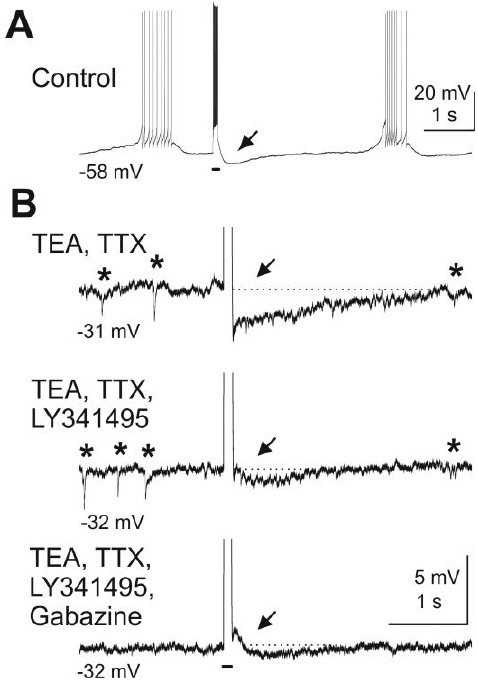
Figure 3. Blockade of mGluRs reduces granule cell-mediated feedback inhibition of mitral cells. Depolarizing current pulses injected into a mitral cell evoked granule cell-mediated feedback IPSPs. ( A ) A depolarizing current pulse (100 ms, 300 pA, indicated by bar beneath the trace) evoked a burst of action potentials followed by an IPSP (at arrow). ( B ) After wash-in of TEA (5 mM) and TTX (1 μM) and current clamp of the mitral cell at ca. −30 mV, spontaneous IPSPs are visible (marked by asterisks above the trace) and current pulses revealed a feedback IPSP (first trace). The mGluR antagonist LY341495 (100 μM) reduces the IPSP in amplitude (second trace). Addition of the GABA A receptor blocker gabazine (10 μM) completely abolishes any remaining feedback IPSP as well as spontaneous IPSPs (third trace). Modified from